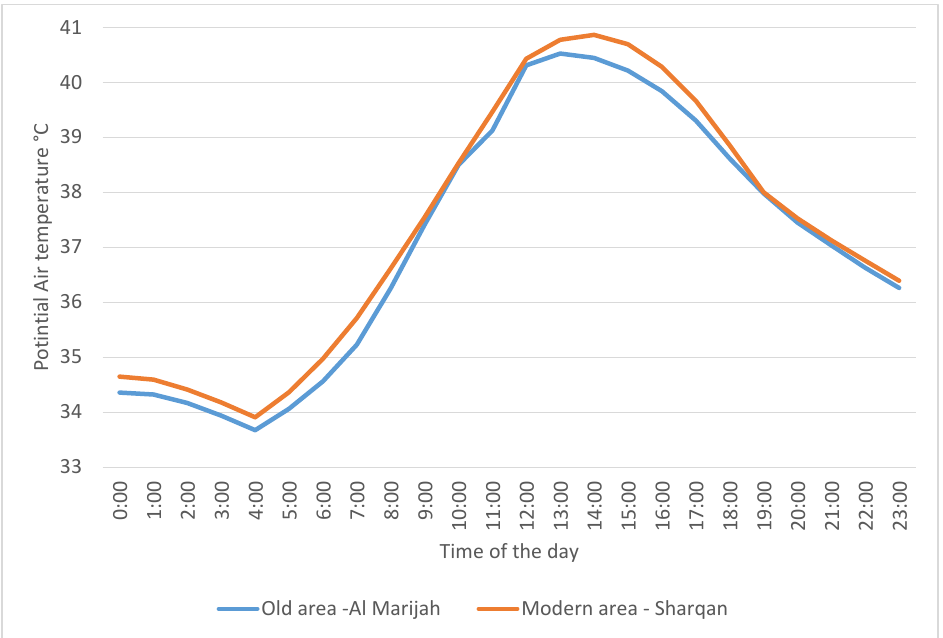
ture was 0.12 °C lower. The difference in the maximum air temperature grew to 0.61 °C at 13:00, 0.96 °C at 14:00, and 1.00 °C at 15:00. This reduction can be attributed to the form of